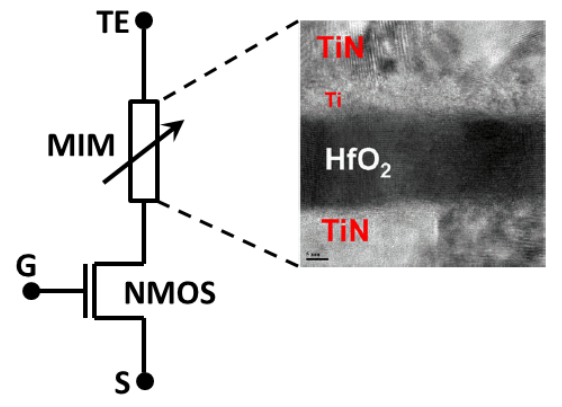
Figure 1. Circuit schematic of the 1T1R cells (G: gate terminal; S: source terminal; and TE: top electrode terminal) and cross-sectional TEM image of the metal–insulator–metal (MIM)